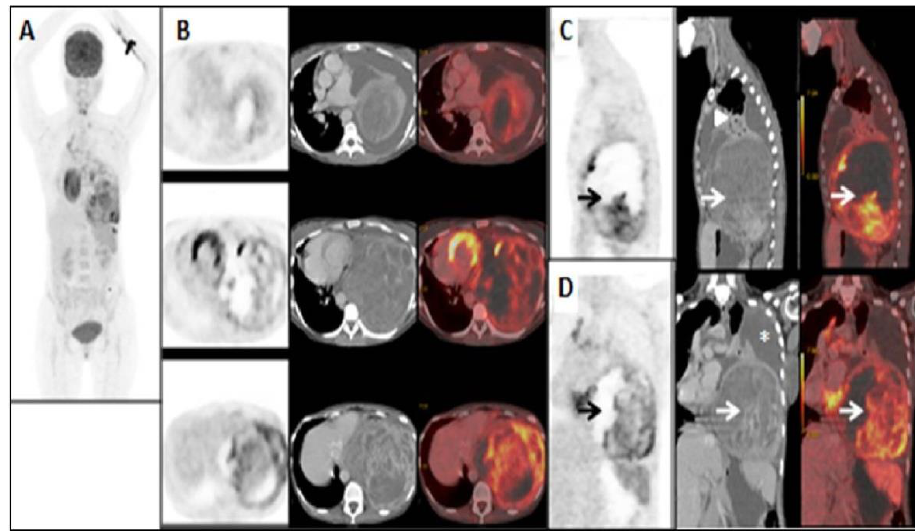
Figure 2. (A)Maximum intensity projection (MIP) PET image (B)Three rows of axial images (PET, CT and fused PET/CT)at different level showing the lesion. The lesion is large in left hemithorax, shifting the mediastinum. It has hypodense and necrotic areas within and shows inhomogeneous FDG uptake (C) Sagittal images (PET, CT and fused PET/CT) showing the lesion. The lesion (marked by arrow) pushes the left lung superiorly with resultant collapse in left lung (arrowhead) (D) Coronal images (PET, CT and fused PET/CT) showing the lesion (marked by arrow). There is reactive pleural effusion seen superior to this lesion (marked by asterisk) and the spleen is seen to be pushed inferiorly by this